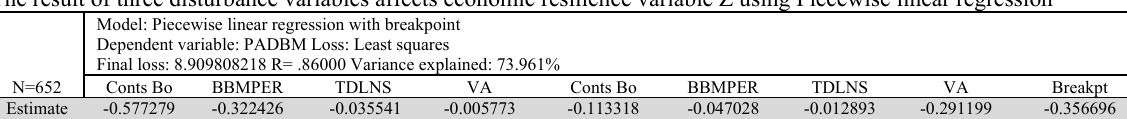
The result of three disturbance variables affects economic resilience variable Z using Piecewise linear regression Model: Piecewise linear regression with breakpoint Dependent variable: PADBM Loss: Least squares N=652